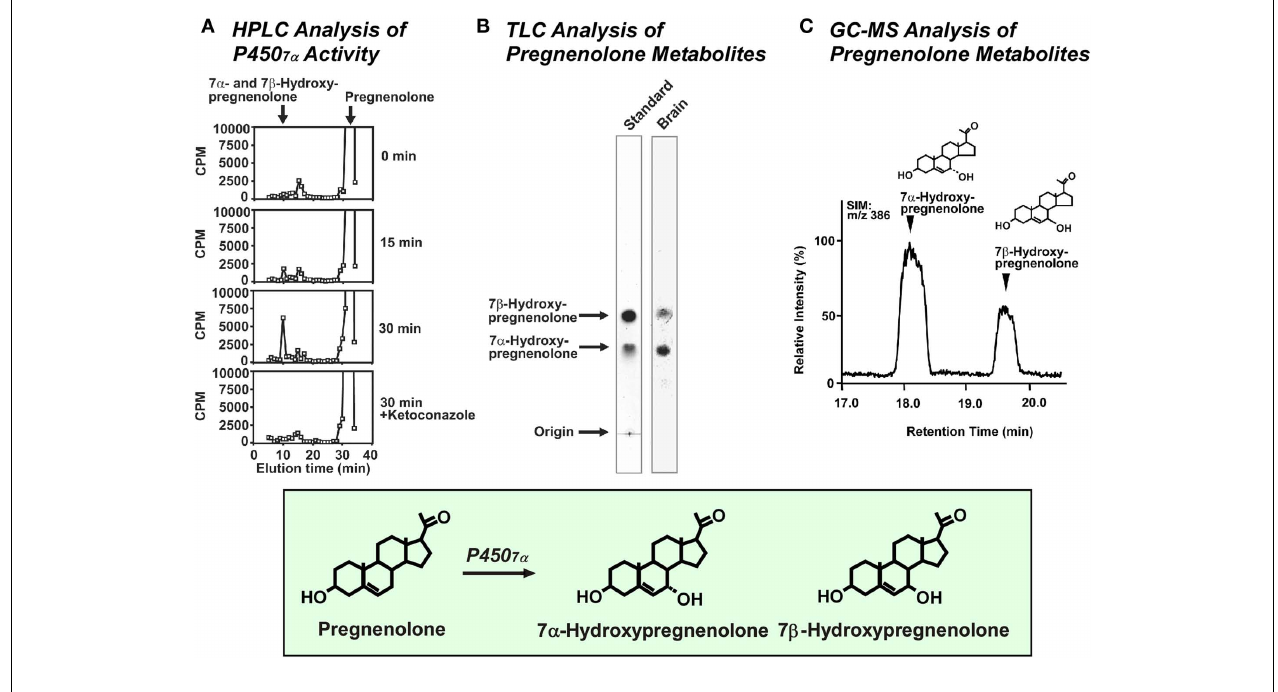
(B) Autoradiography of the unknown pregnenolone metabolites (right column) and standard steroids 7 α - and 7 β -hydroxypregnenolone (left column) onTLC under the same condition as in (A) . (C) GC–selected ion monitoring (SIM) mass trace of m / z 386 in the extract from quail brain homogenates.The arrowheads indicate the retention times of 7 α -hydroxypregnenolone and 7 β -hydroxypregnenolone. SeeTsutsui et al. (2008) for